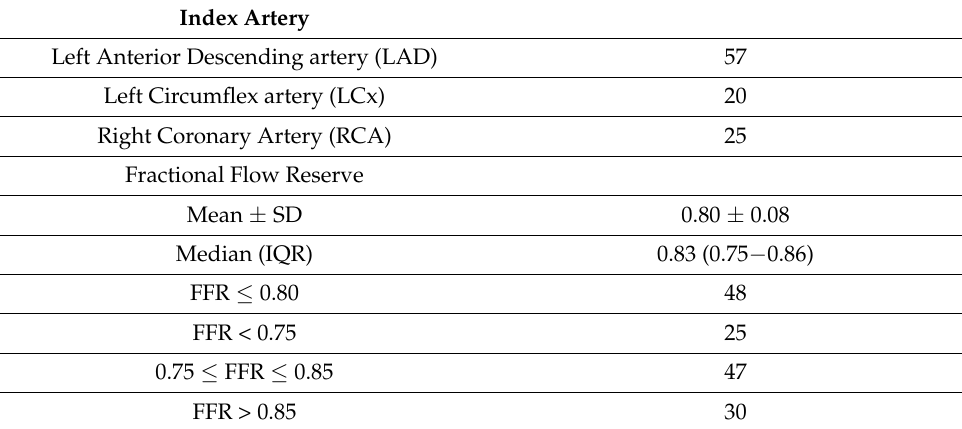
Table 2. Baseline lesion characteristics ( n =